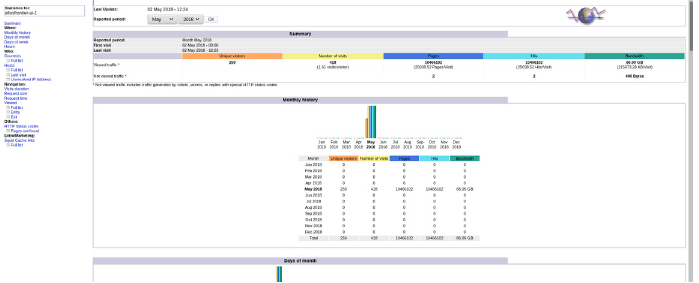
Figure 2. Kibana Dashboard: histogram of concurrent queries (top right) and statistics of not-cached Figure 4. AWstats monitoring page